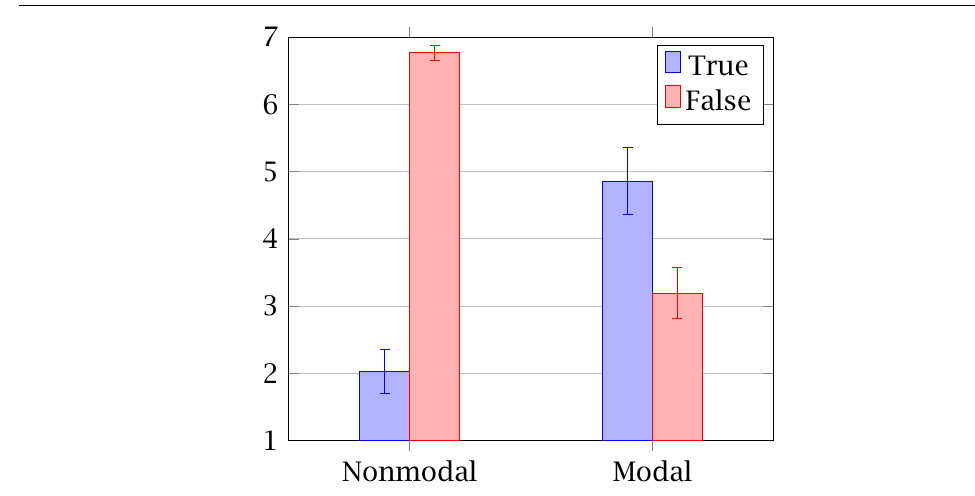
Figure 2 Mean ratings by condition for Experiment 2 . Error bars show standard error of the